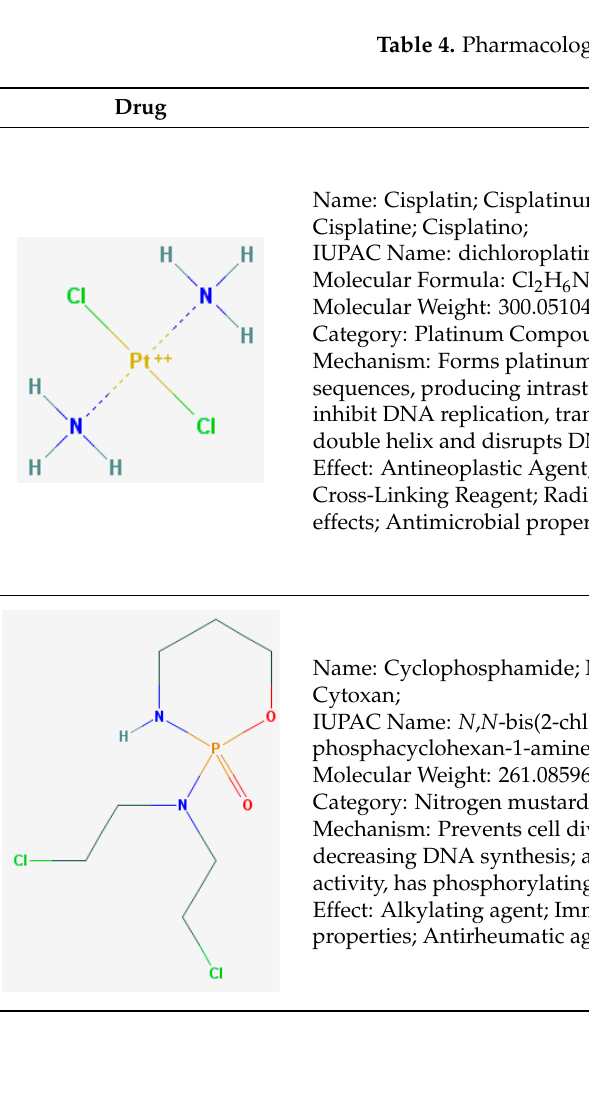
Table 4. Pharmacological properties and pharmacogenetics of selected antineoplastic